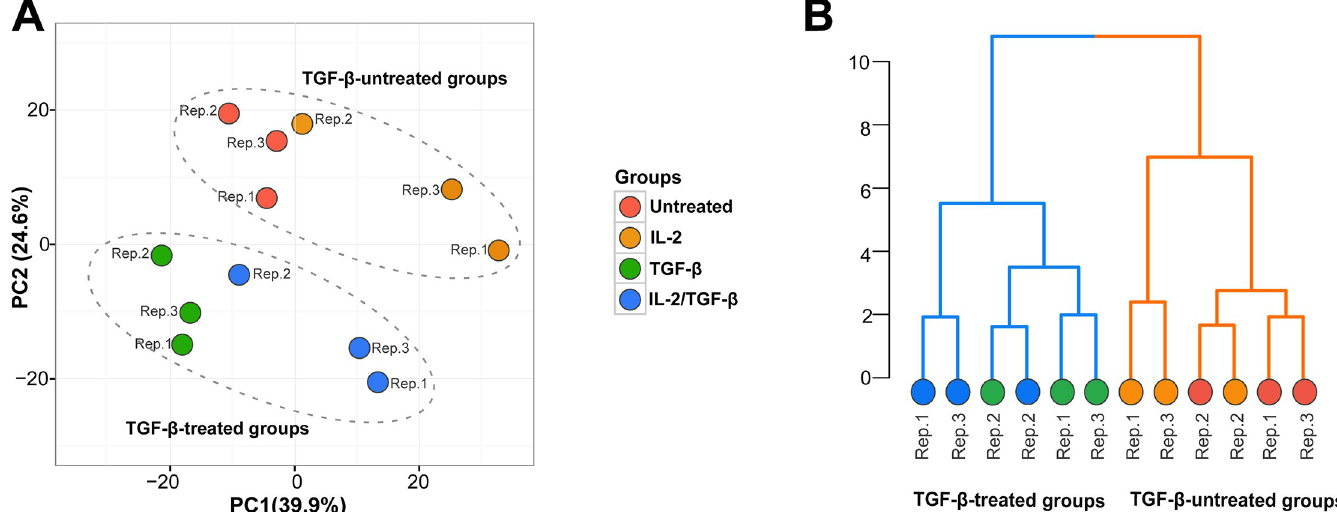
Fig 2. Principal component analysis and hierarchical clustering. (A) PCA plot (PC1 vs . PC2) of all 12 RNA samples. The numbers in parenthesis beside the PC labels denote the percentage of variance in the data explained by the respective PC. Clusters of TGF- β -treated (TGF- β and IL-2/TGF- Β ) and TGF- β -untreated (Untreated and IL-2) groups, which separated along PC2, are circled. (B) Dendrogram from hierarchical cluster analysis of all the samples based on their expression profiles. Clustering was done using the Ward’s method with the “maximum” distances measure provided as the dissimilarity matrix. Dendrogram branches are coloured by TGF- β treatment: TGF- β -treated groups (blue) and TGF- β -untreated groups (orange). The dots represent biological samples coloured according to TGF- β treatment they received. Biological replicates (Rep.1-3) for each treatment have the same colour.